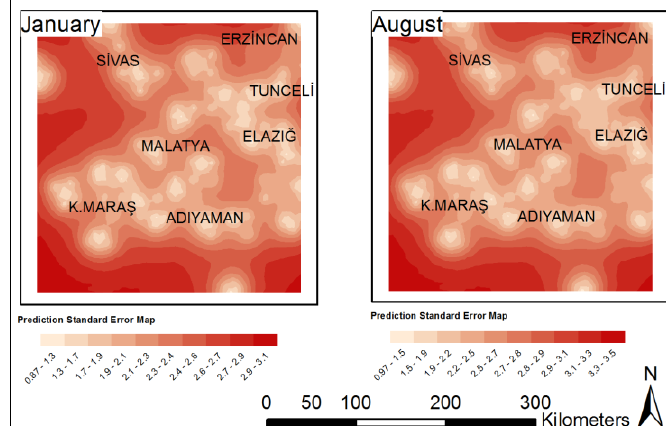
Figure 4. Maps of prediction error map for January (with greatest CV) and August (with lowest CV)